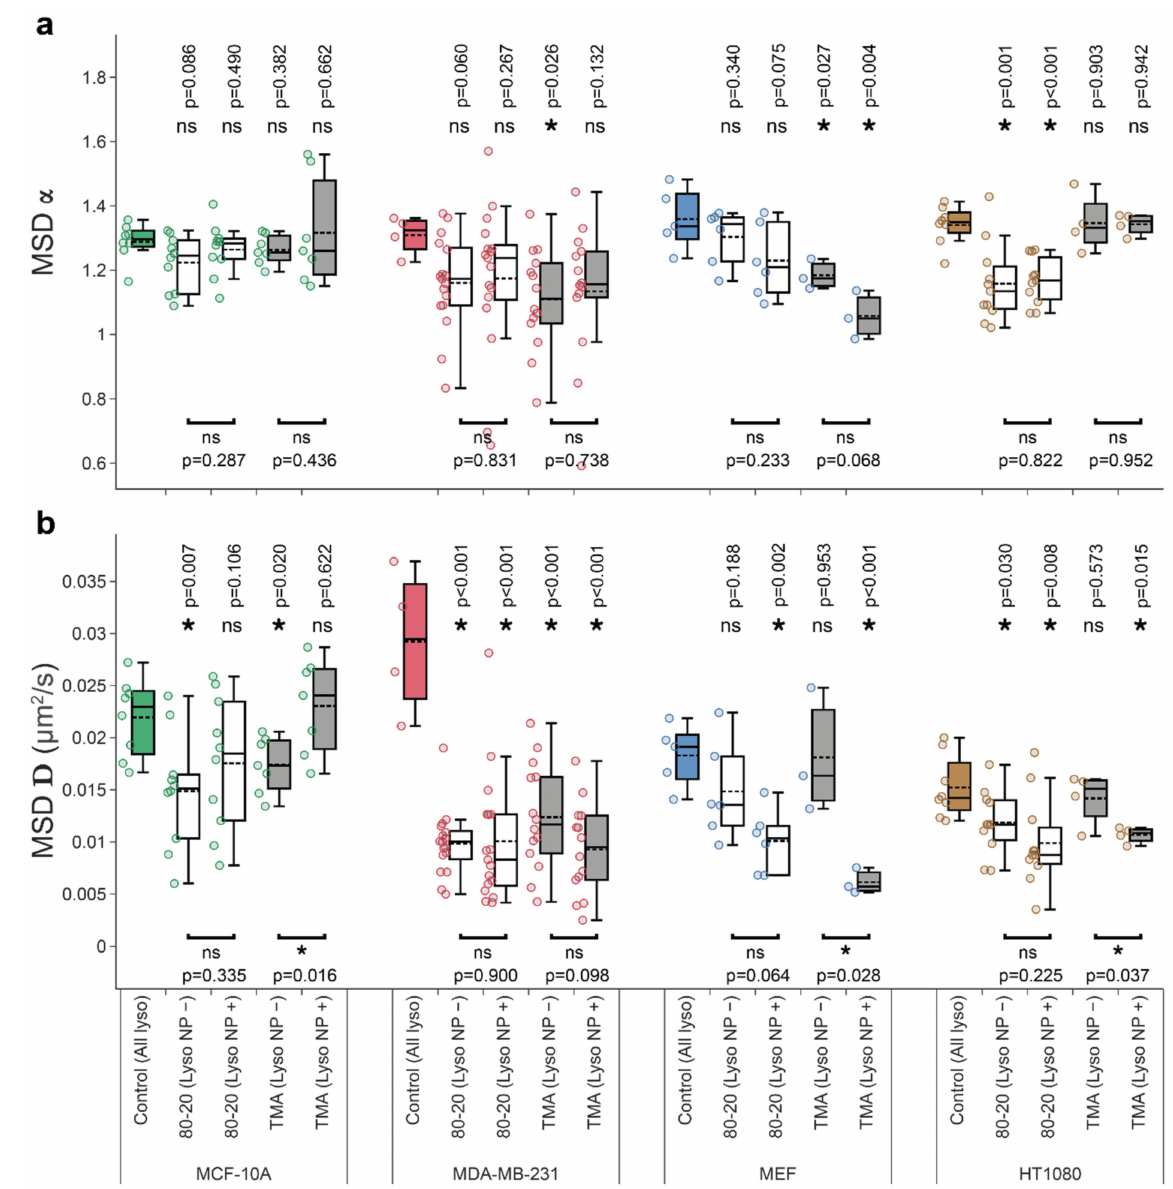
Figure 4. Cell type-specific effects of nanoparticle cargos on lysosome movement parameters. MCF- 10A non-cancerous breast epithelial cells vs. MDA-MB-231 breast adenocarcinoma and normal mouse embryonic fibroblasts (MEF) vs. HT-1080 fibrosarcoma were untreated (Control), or treated with mixed-charge 80:20 or purely cationic TMA NPs. Trajectories for all lysosomes from each cell were pooled together to compute ( a ) exponent α and ( b ) diffusion coefficient D . For NP-treated samples, wavelet-based co-movement algorithm (see Materials and Methods) was used to further subdivide lysosomes into those carrying NP cargos (Lyso NP+) and those without detectable NP cargos (Lyso NP − ). Data are displayed as box-and-whisker plots; boxes delineate the lower and upper quartiles of the data, middle lines show median values, dashed lines show mean vales, colored dots show lysosome dynamics parameters for each cell and whiskers show upper and lower